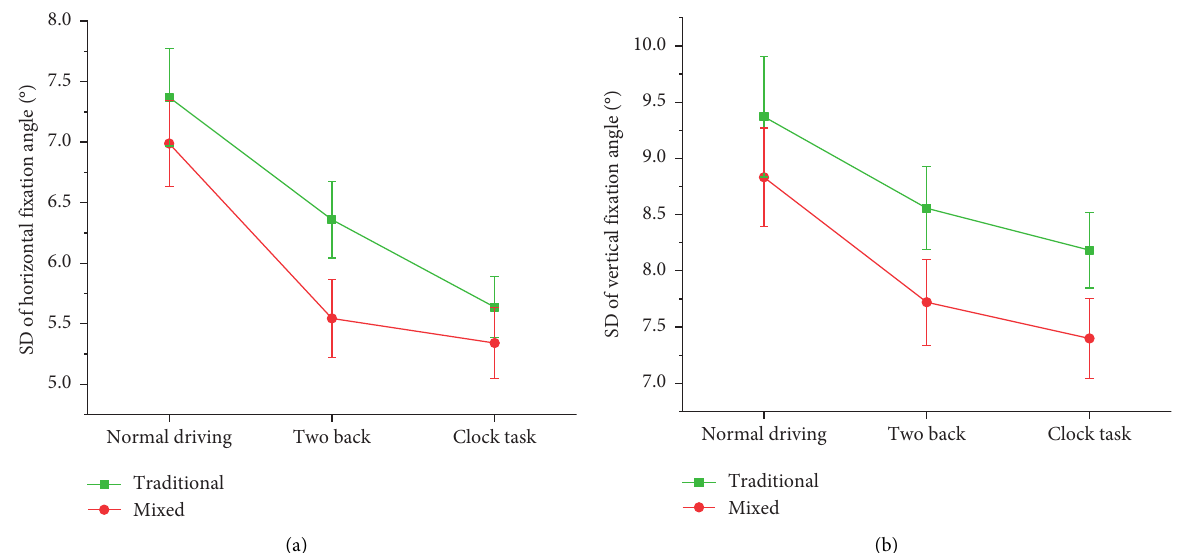
Figure 8: Interaction effect of driving tasks and traffic environment on the SD of the (a) horizontal fixation angle and (b) vertical fixation angle.